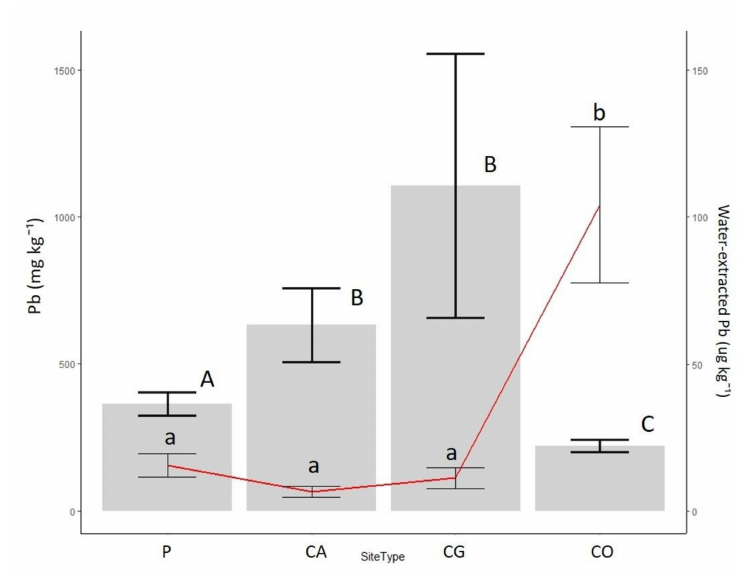
Figure 3. Site type total (mg kg − 1 : column, primary y axis) and water-extractable lead concentrations ( µ g L − 1 : line, secondary y axis). Di ff erent letters denote significant mean di ff erence at p < 0.05. Error bars are ± 1 S.E.